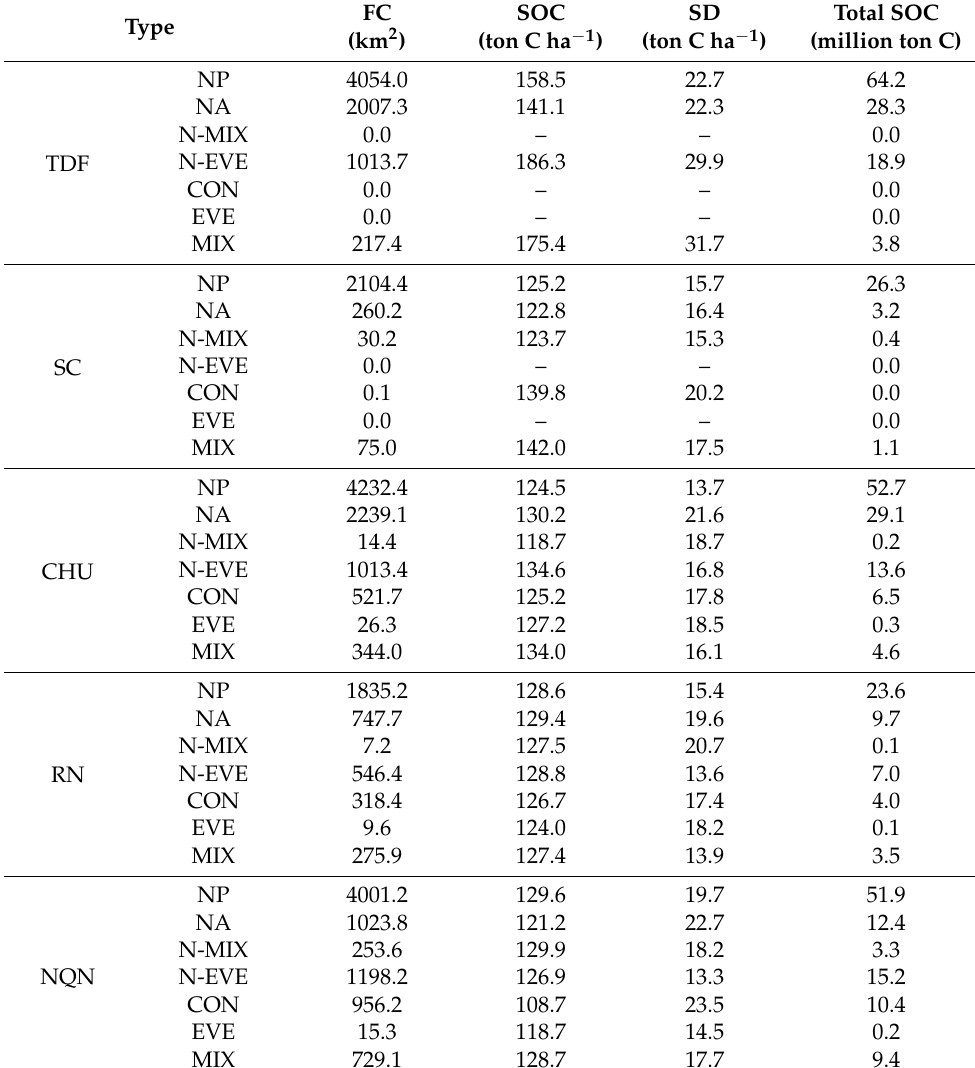
Table A1. Forest cover (FC, km 2 ), mean soil organic carbon content (SOC, ton C ha − 1 ) and stan-